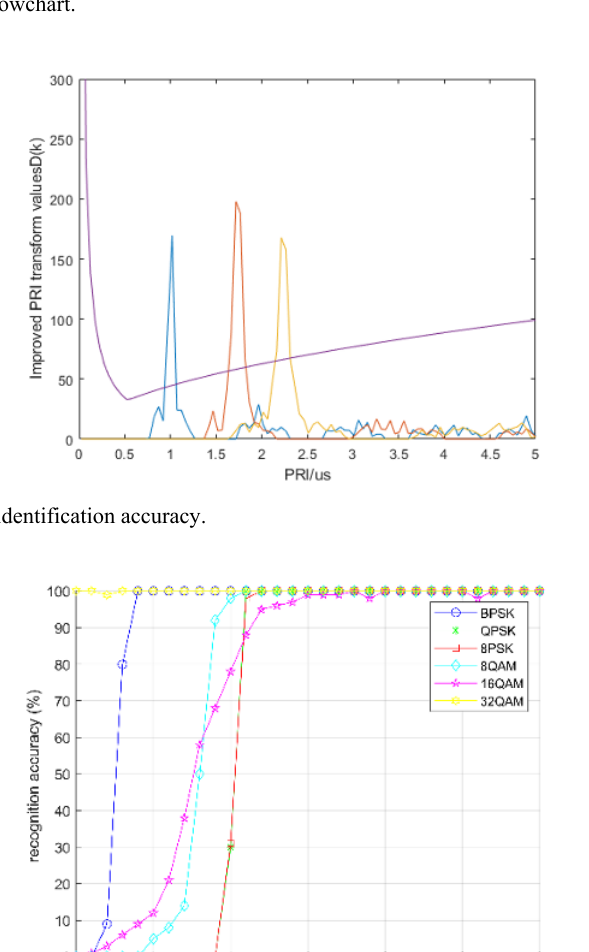
Fig. 1. Algorithm flowchart.